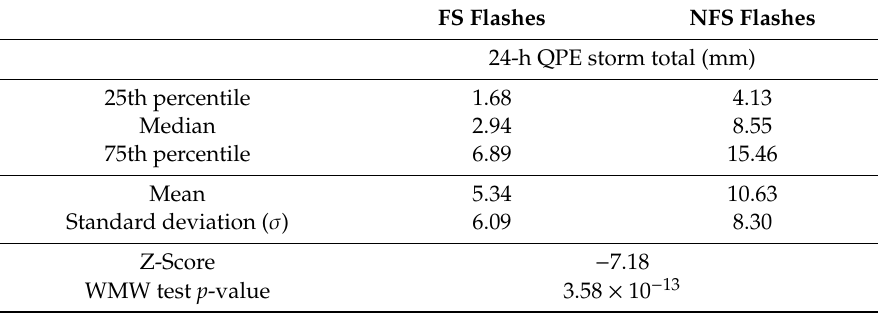
Table A2. Statistics of 24-h rainfall totals at FS and NFS flash